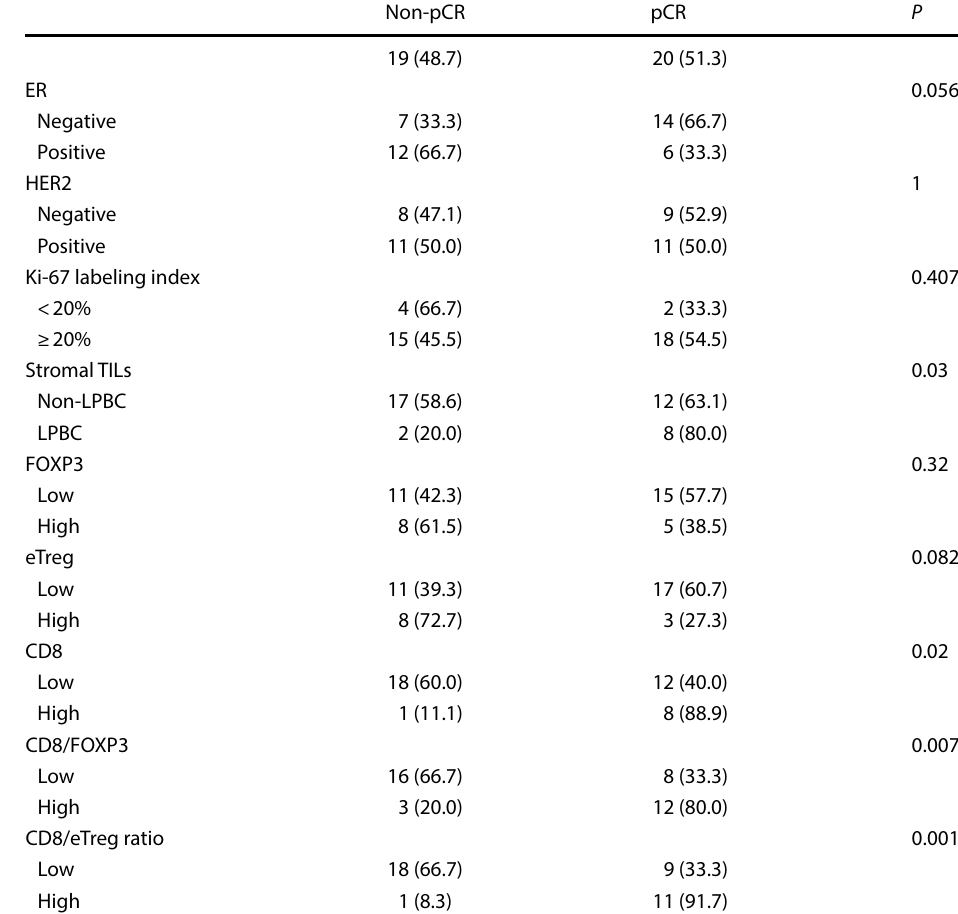
Table 3 Pathological response according to tumor subtype and TIL subpopulation